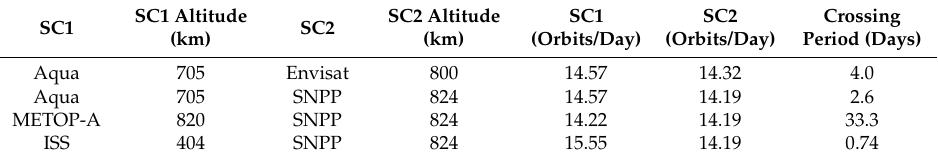
Table 1. Orbit altitude and frequency of opportunities for several LEO spacecraft pairs.